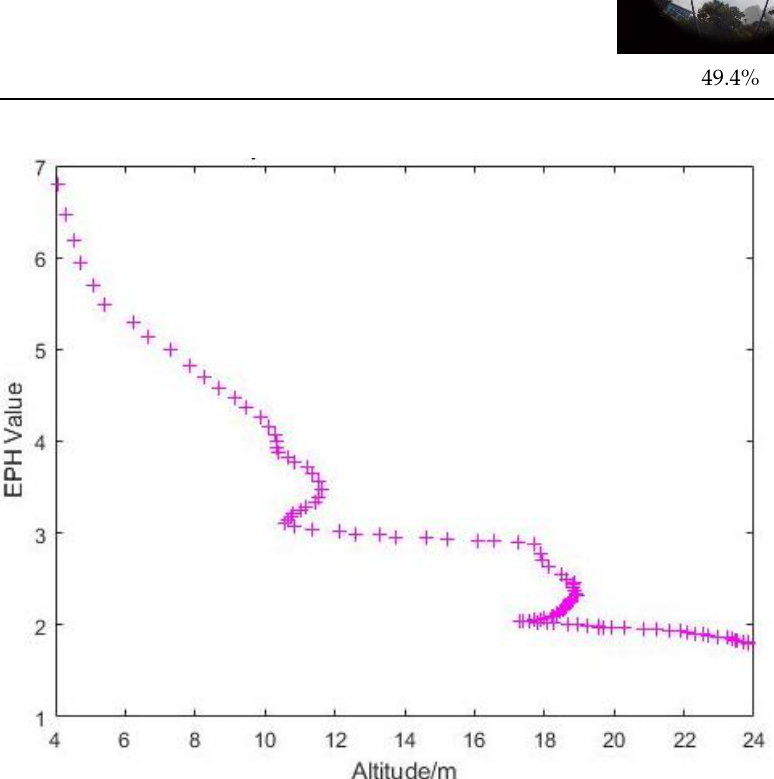
Figure 21. Graph of EPH vs. Altitude at the Admin Building.